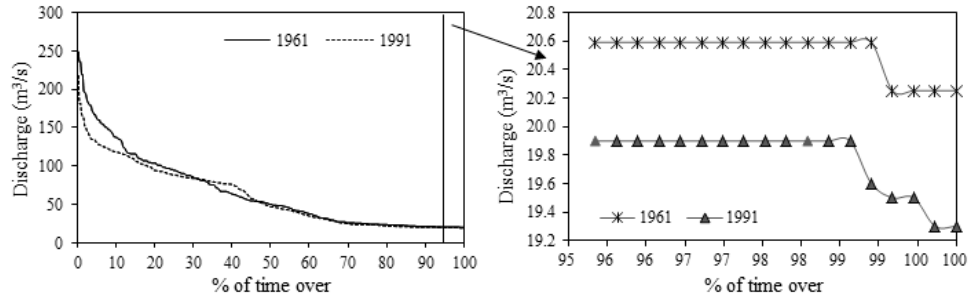
Figure 5. An example of flow duration curve for pair 1964 vs. 1985 in Phase 1 and Phase 3 (flow duration curves for other selected pairs in the low level of forest harvesting n period can be found in Figure A2).